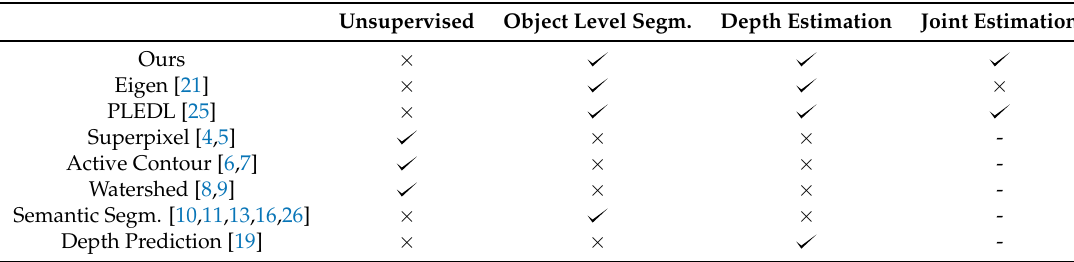
Table 1. A comparison of different types approaches. Object Level